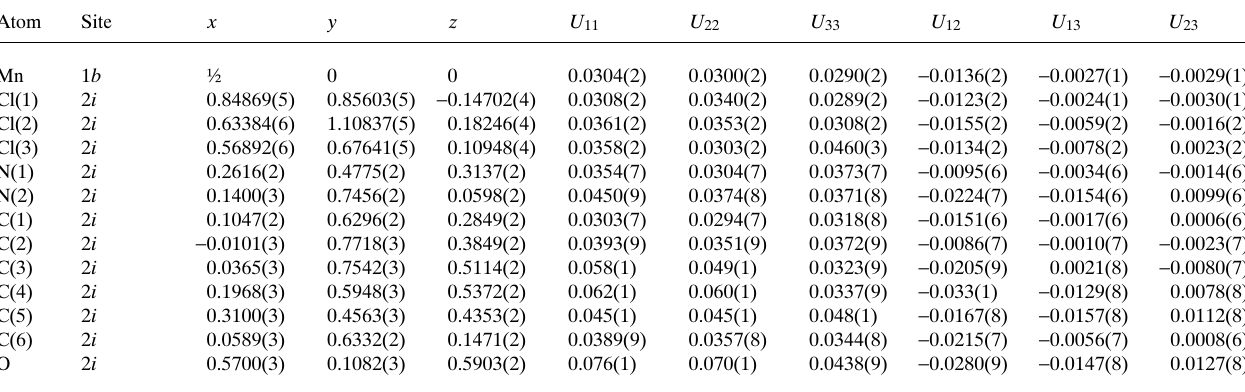
Table 3. Atomic coordinates and displacement parameters (in Å 2 ) .